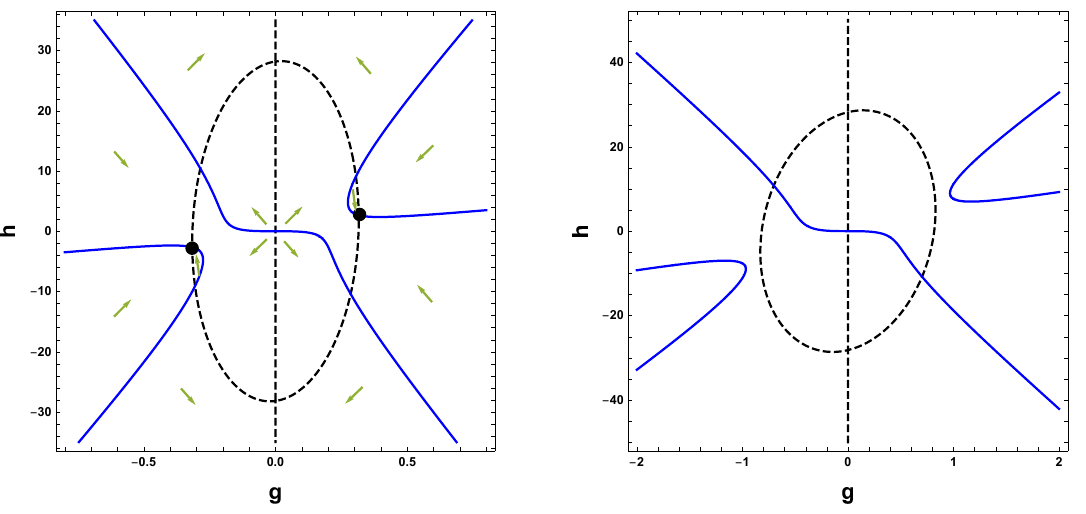
Figure 1 . Contour plots for β g (black, dashed) and β h (blue, solid) for ǫ 1 = 0 . 1, α = 1 / 3, N = 8000 (left), N = 1200 (right). RG flow direction (towards IR), determined by the signs of β g,h in various domains of the plot, are indicated with arrows. When N = 8000 (left) the RG flow has a pair of IR stable fixed points on the ( g, h ) plane (indicated with solid black dots). This fixed point for α = 1 / 3 disappears for N N crit ( α = 1 / 3) = 2547. In particular, it is absent for N = 1200 ≤